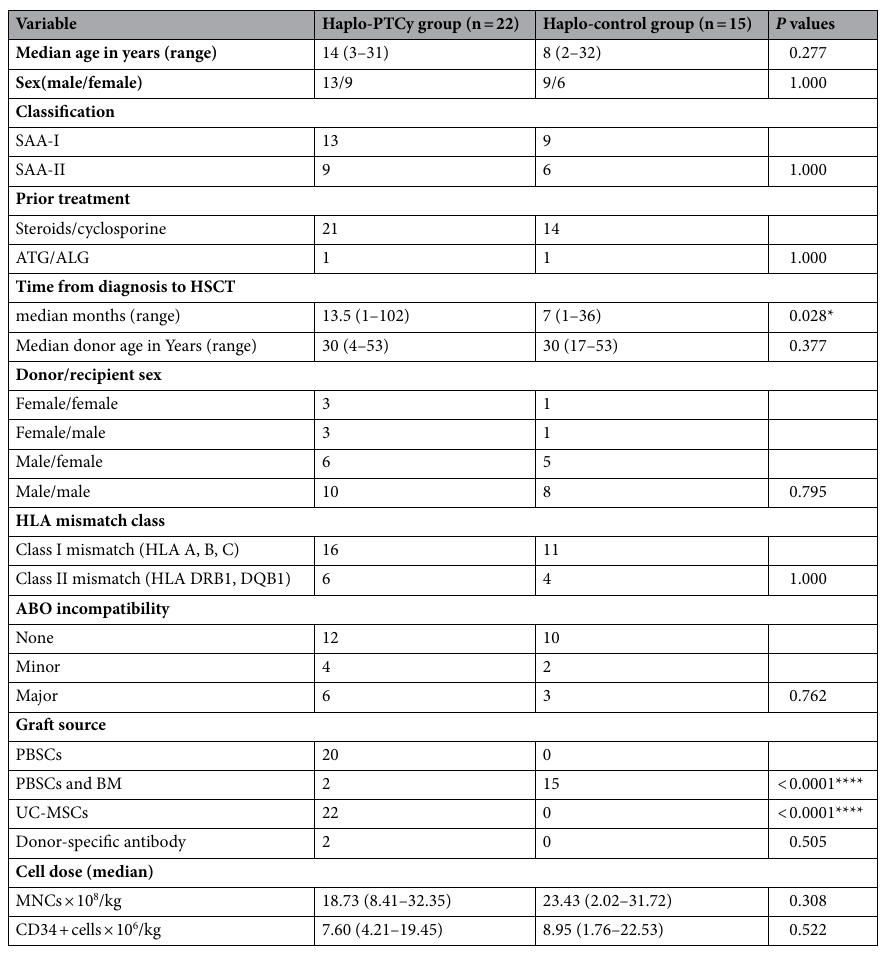
Table 2. Patient characteristics and transplant-related parameters in the haplo-HSCT groups. Continuous variables were expressed as median values and ranges; Discrete variables were expressed as counts (%). P